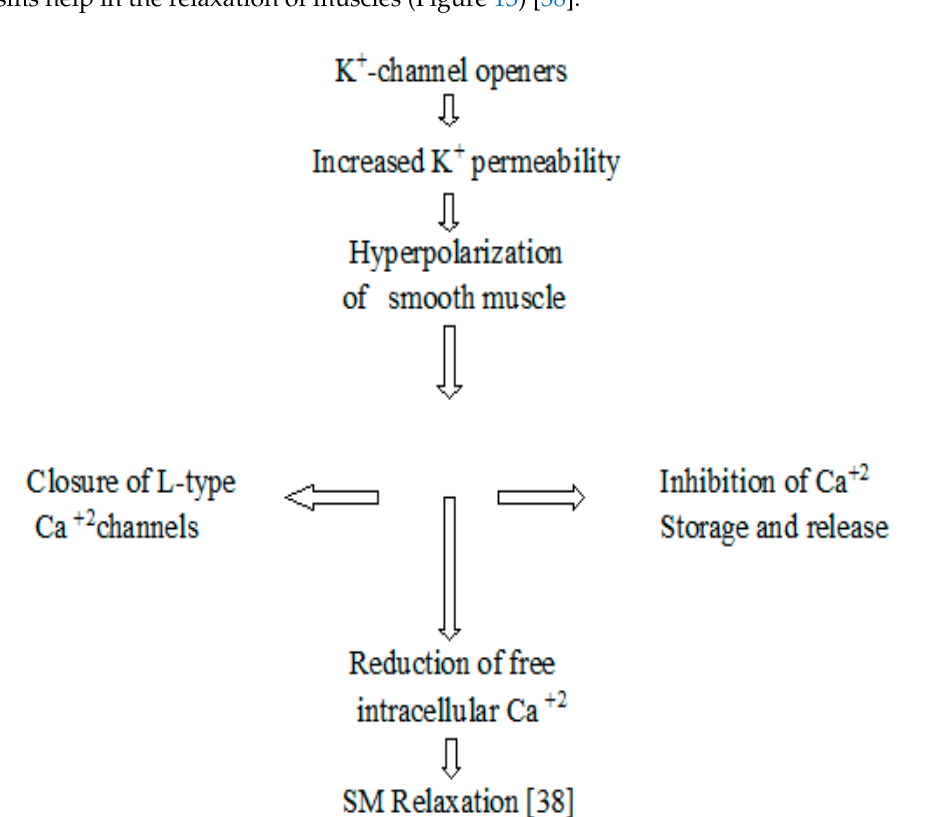
Figure 13. The schematic diagram of proposed mechanism of smooth muscle relaxation by K +